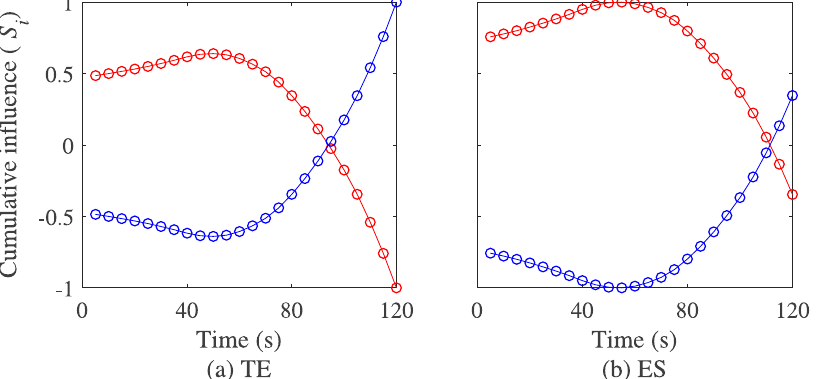
Figure 1. Illustration of the cumulative influence function estimated with transfer entropy (TE) and directed event synchronization (ES) on segmented raw datasets (circle) and interpolated dataset (solid line) overs the entire length of the observation. The plot in red indicates the influence of individual 1 on individual 2 and the plot in blue is the influence of 2 on